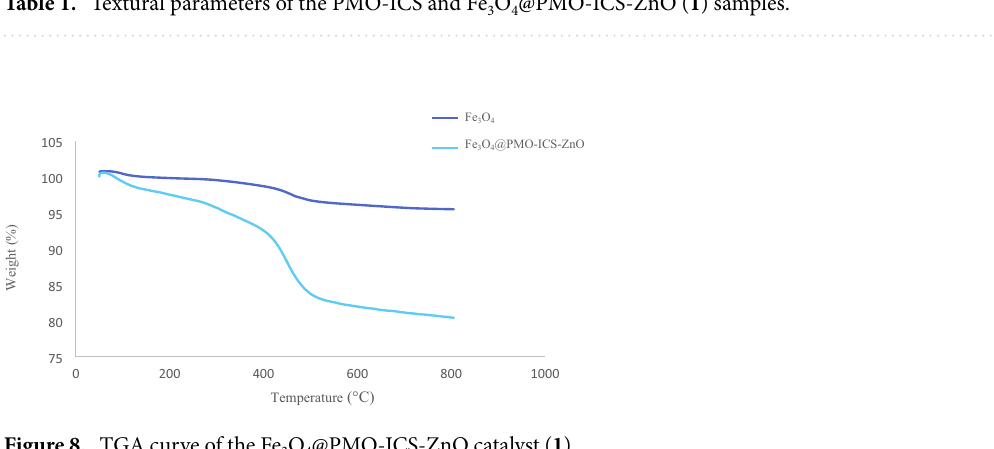
Table 1. Textural parameters of the PMO-ICS and Fe 3 O 4 @PMO-ICS-ZnO ( 1 ) samples.